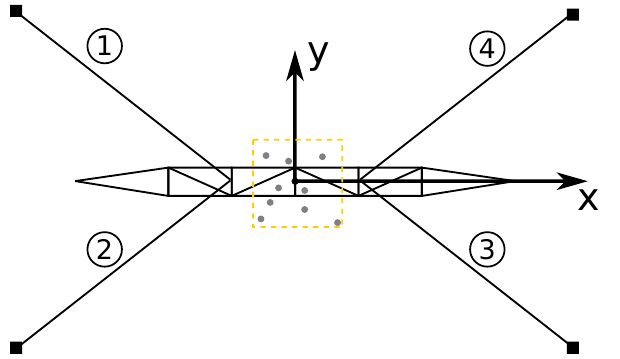
Figure 16. Tower displacement simulation diagram. The tags 1, 2, 3, and 4 shows the location of the tensor and accelerometer sensors of each